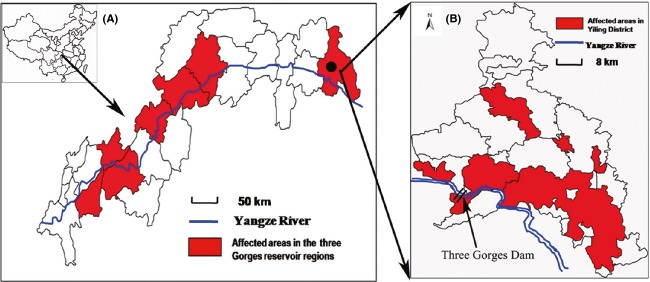
The location of Yiling District (study areas), Hubei province, P.R. China. (A) Current distribution of pine wilt disease throughout the counties in the Three Gorges reservoir regions (2013); (B) Current distribution of pine wilt disease areas in Yiling District. (Data obtained from the Station of Pest and Disease Control and Quarantine of Yiling District, Hubei province, P.R. China).